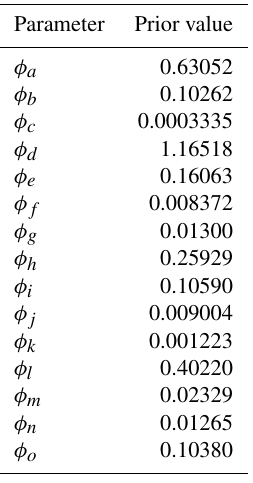
Table 1. Prior values for parameters of the Tóth et al. (2015) pedo- transfer functions used in experiments.